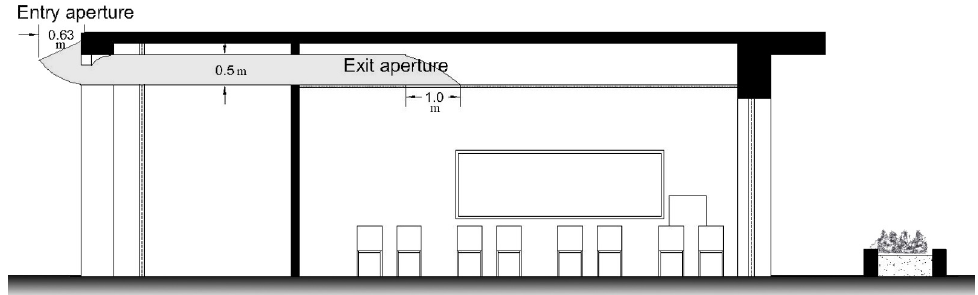
Figure 11. Ceiling plan of a typical classroom showing the suggested southern anidolic duct.